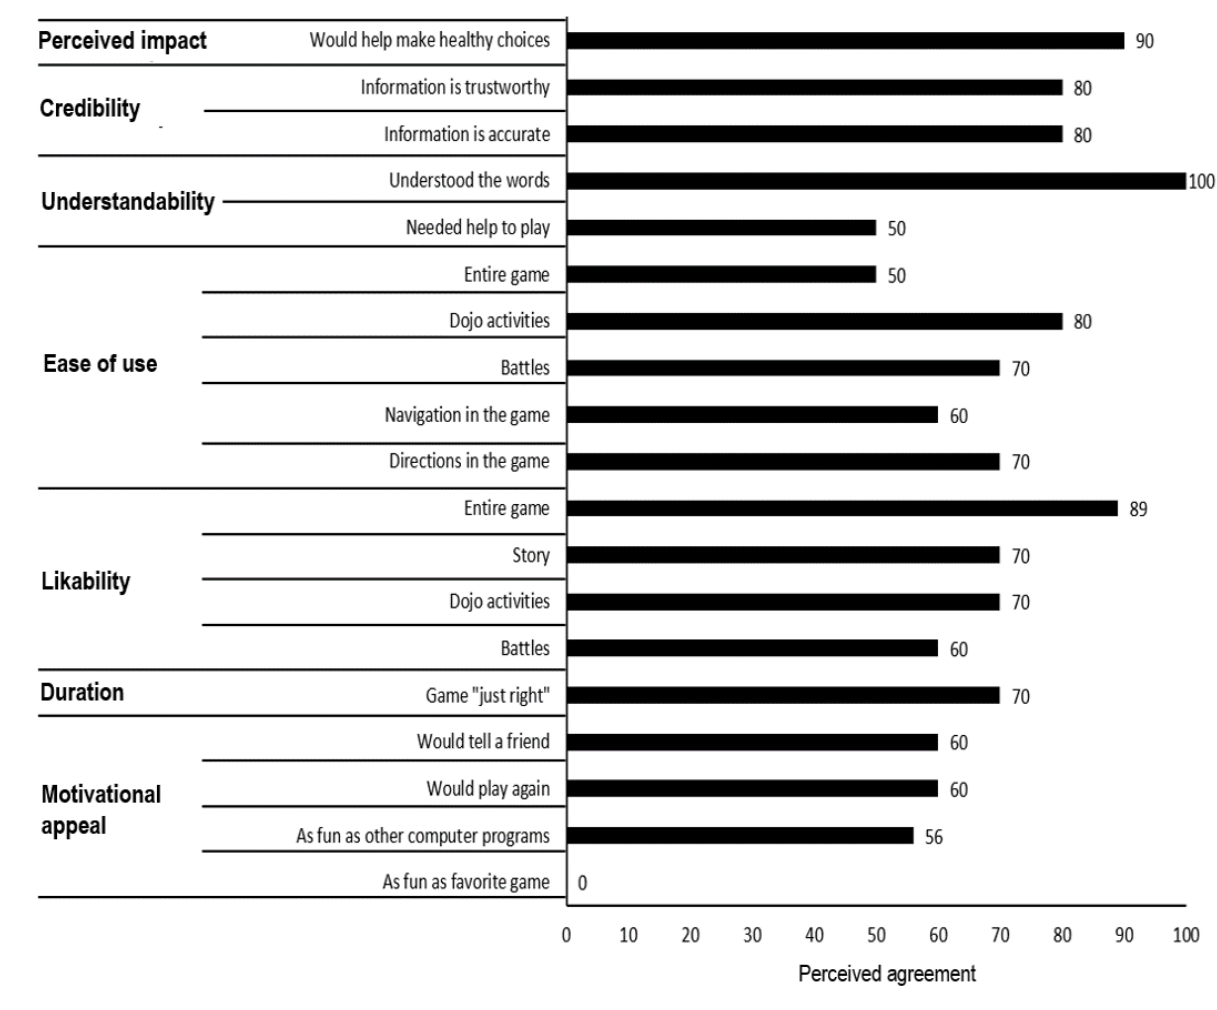
Figure 4. Young adolescent ratings for prototype levels 1 and